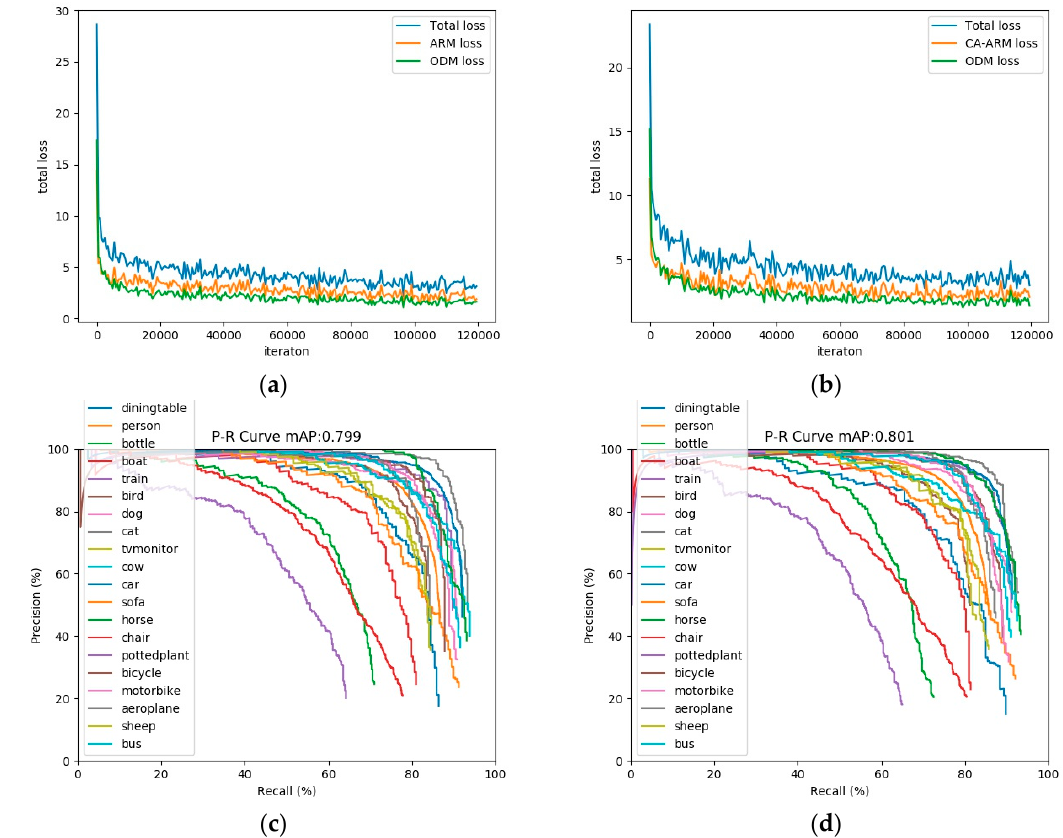
Figure 17. Loss function and P-R curve display on the VOC dataset. ( a ) The loss function of the original RefineDet; ( b ) The loss function of the proposed method; ( c ) The P-R curve of the original RefineDet; ( d ) The P-R curve of the proposed method.